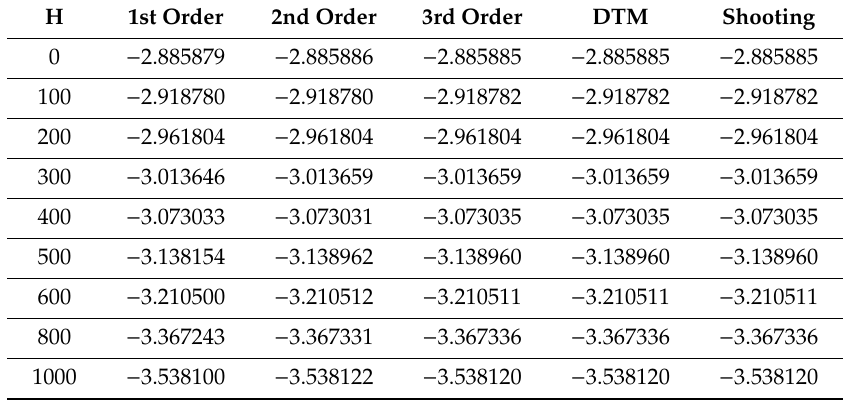
Table 2. Comparison of the DTM and shooting results with the SHAM approximate results for. G (cid:48) ( 1